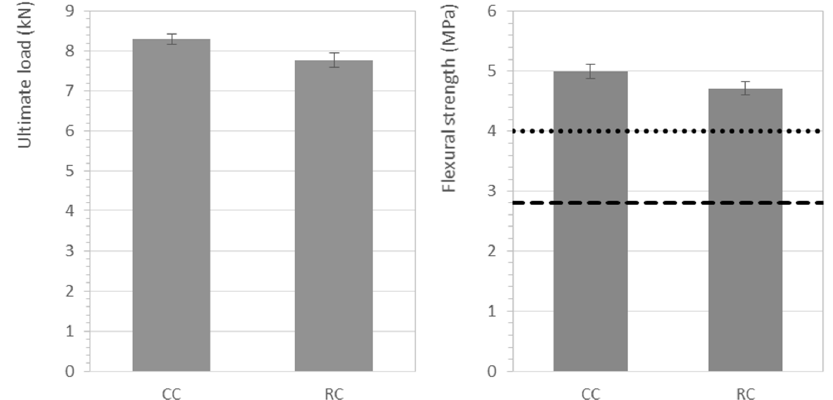
Figure 5. Mechanical characterization of the conventional (CC) and recycled (RC) curb units, where the dashed and dotted lines represent the Class 1 and 2 thresholds respectively.